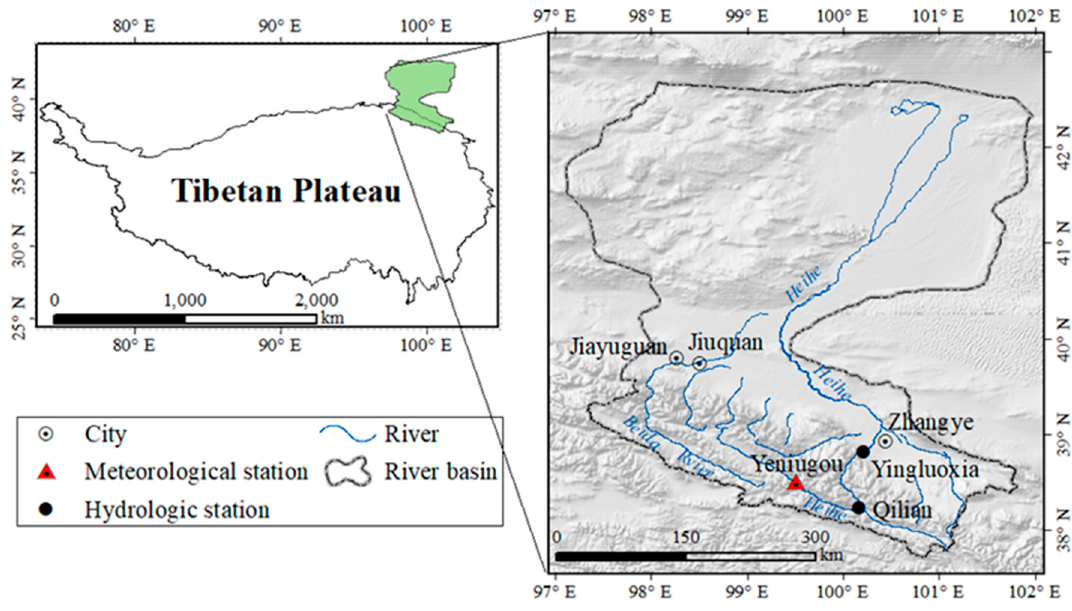
Figure 1. The Heihe River Basin and sampling site locations.